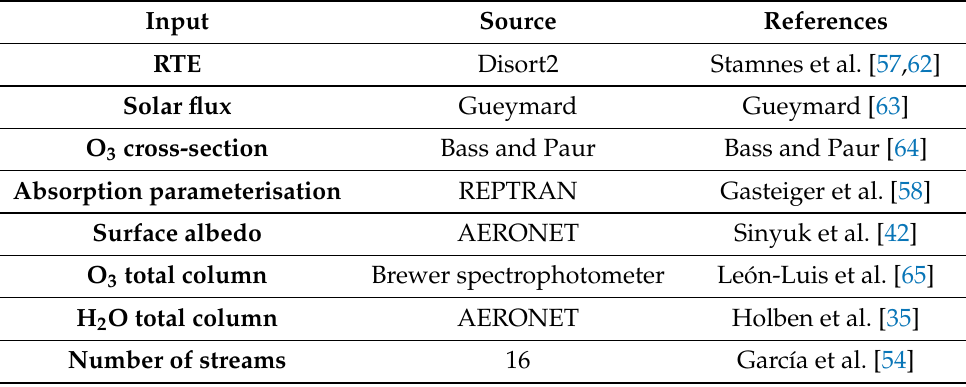
Table 1. Input parameters to the LibRadtran model, their sources, and corresponding